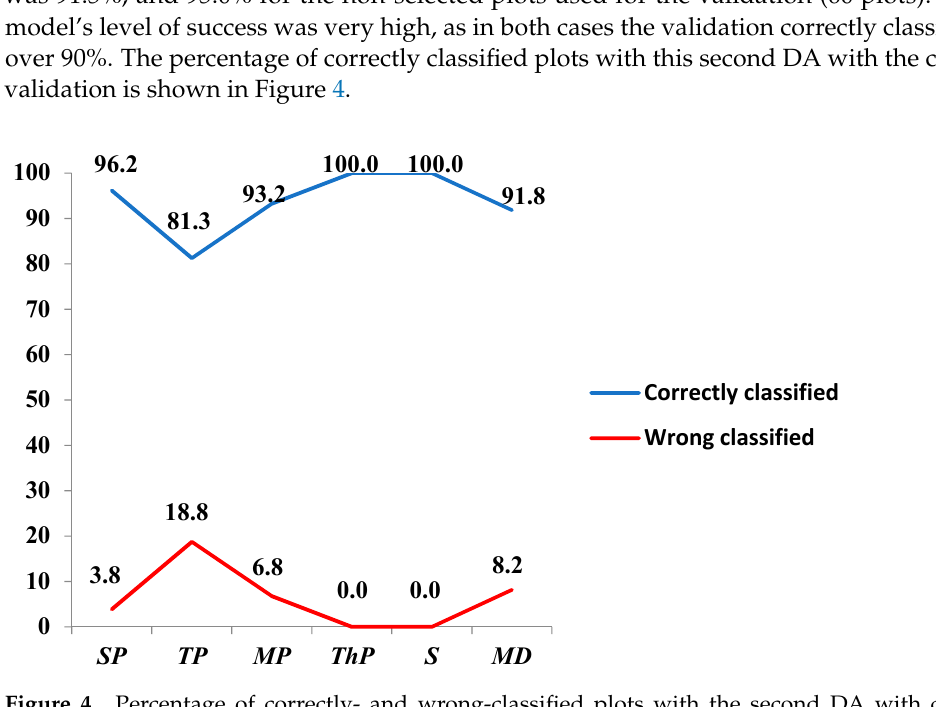
Figure 4. Percentage of correctly- and wrong-classified plots with the second DA with cross-validation. (Legend: SP : seedling poles; TP : thin poles; MP : medium poles; ThP : thick poles; S : stratified; MD : multi-diameter).